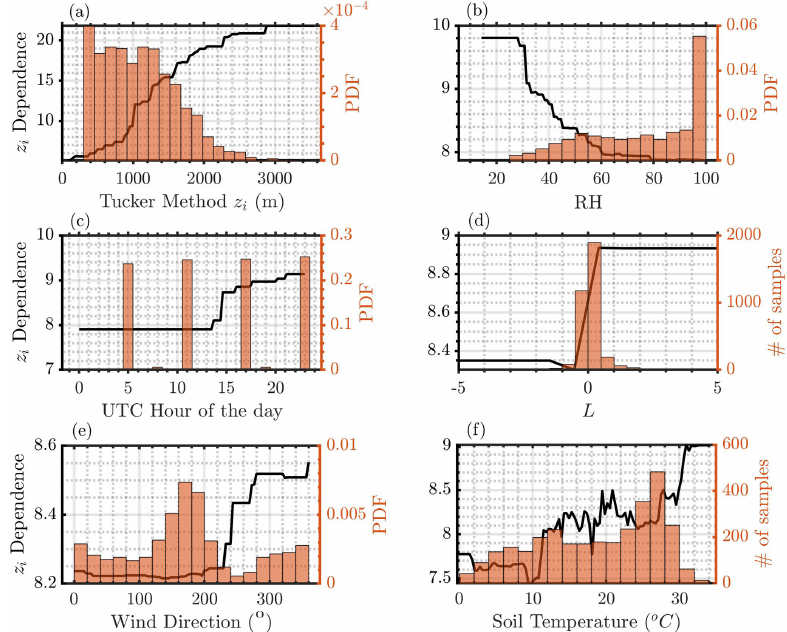
Figure 9. RF partial dependence during all conditions from (a) the Tucker method z i , (b) relative humidity, (c) hour of the day, (d) Monin– Obukhov length, (e) surface wind direction, and (f) soil temperature to boundary layer height at the central facility. High dependence shows more sensitivity of the RF model to the bin of feature values.